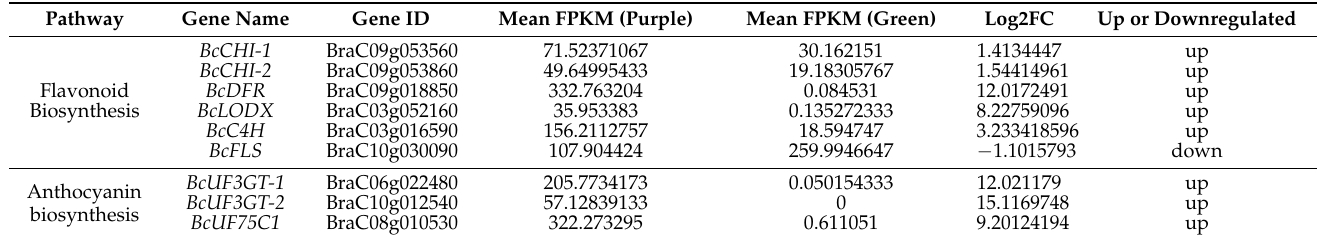
Table 3. Anthocyanin and Flavonoid Biosynthesis Pathway DEGs.